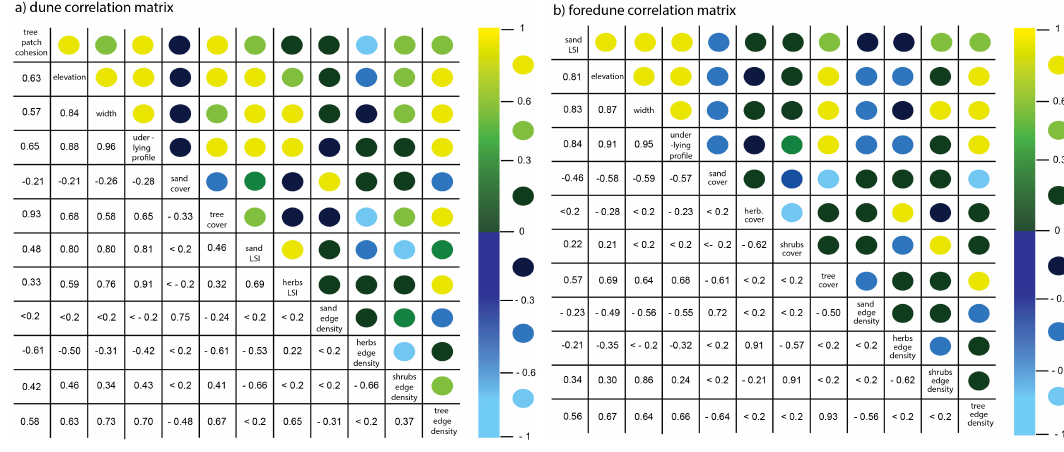
Figure 9. Correlation matrices of selected geomorphology and landscape metrics for: ( a ) dune and ( b ) foredune. In the matrices, low correlation is indicated by green (r up to 0.3) and blue dots (r up to − 0.3); medium correlation is indicated by light green (0.3 ≤ r ≤ 0.6) and light blue ( − 0.3 ≤ r ≤ − 0.6) dots; high correlation is indicated by yellow (0.6 ≤ r ≤ 1) and very light blue ( − 0.6 ≤ r ≤ − 1) dots.